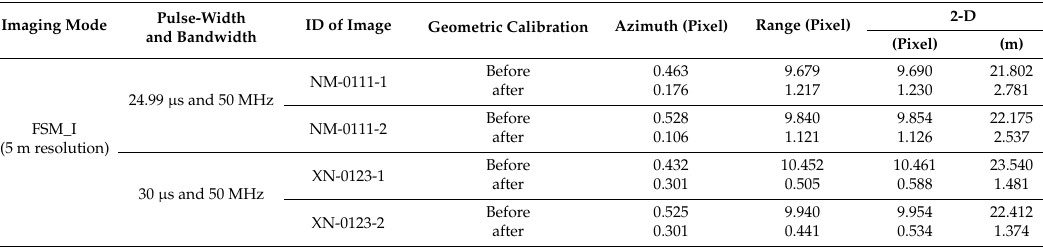
Table 4. Comparison of geometric positioning accuracy before and after correcting for geometric calibration parameters.